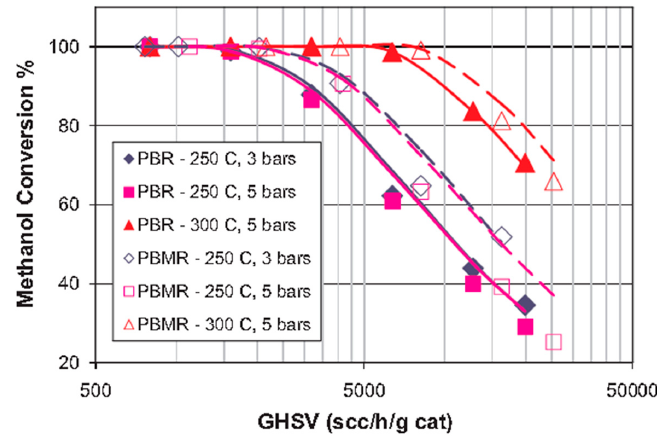
Figure 13. Simulation (lines) and experimental (symbols) results of MSR reaction carried out in a supported Pd-Ag MR and in a conventional reactor: Methanol conversions vs. gas hourly space velocity (GHSV) at different reaction temperature and pressure. With permission of reprint of Elsevier from Israni and Harold [47].